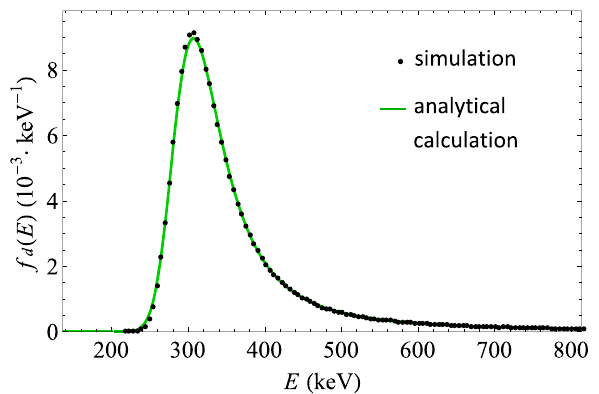
Fig. 2 Ionizationlossspectraof150GeV/c π − mesonsin1mmsilicon target for different values of l d (specified in the legend). The particles incident along (110)